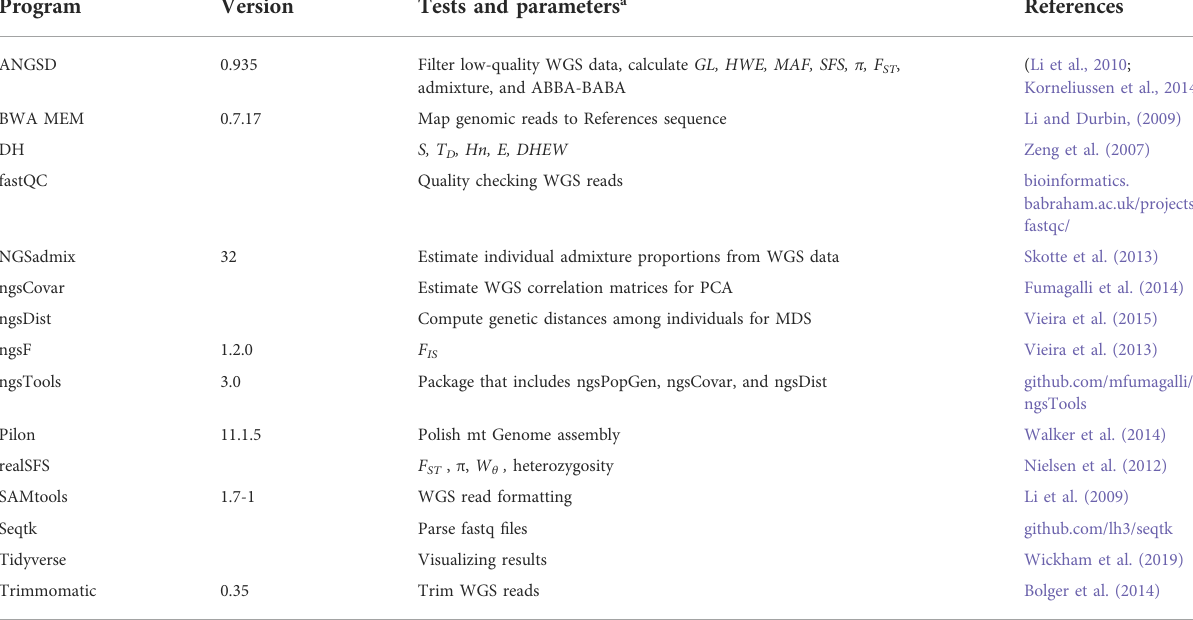
TABLE 2 Programs, versions, tests and parameters estimated from WGS